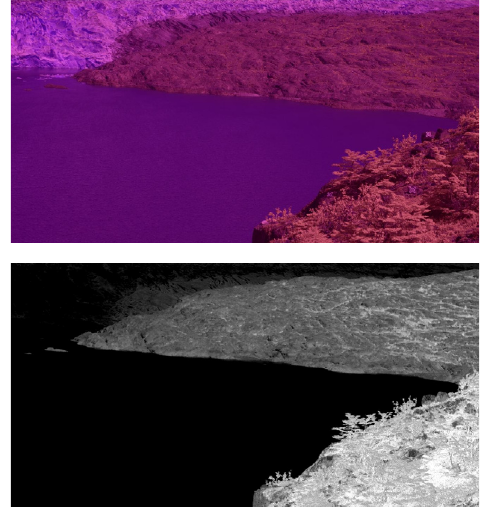
Figure 9. Image of modified camera; grey value spread NDWI (top to bottom).